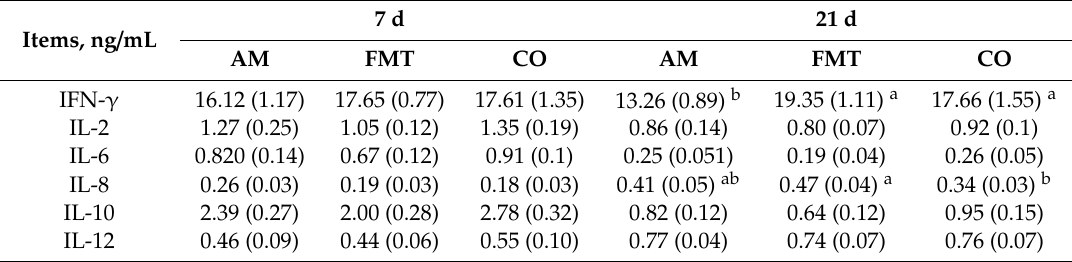
Table 2. Concentration of serum cytokines of piglets in the amoxicillin (AM), fecal microbiota transplantation (FMT), and control (CO) groups on days 7 and 21. Items, ng /